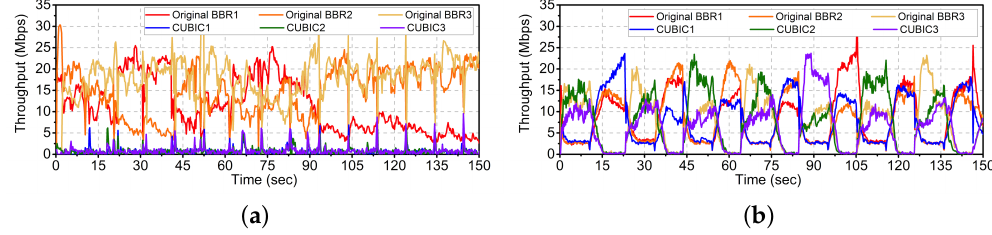
Figure 14. Three original BBR vs. three CUBIC: ( a ) shallow buffer (0.8 BDP); and ( b ) deep buffer (5